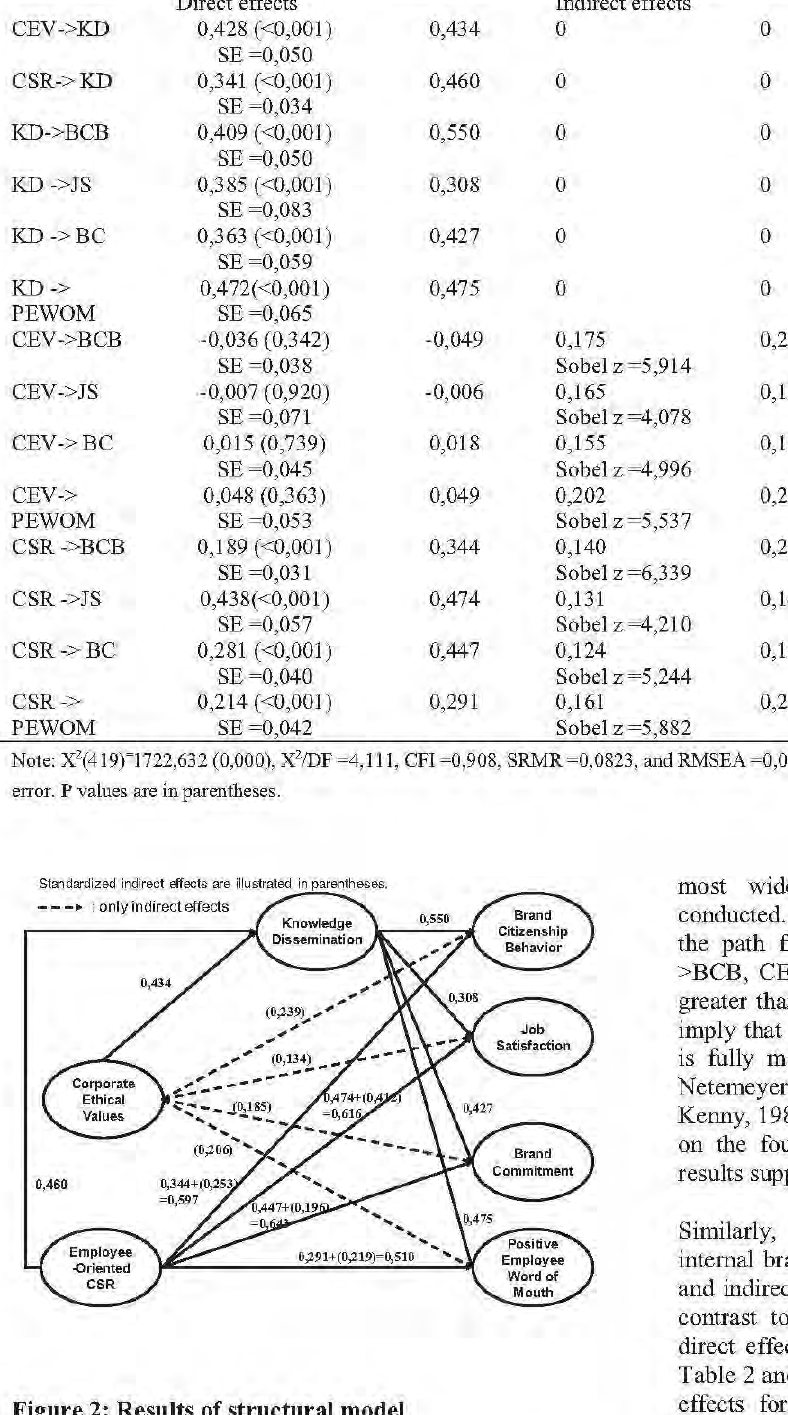
Figure 2: Results of structural model The impact of CEV on internal branding benefits is decomposed into direct effects and indirect effects by way of knowledge dissemination. As shown in Table 2 and Figure 2, the direct effects of CEV on four internal